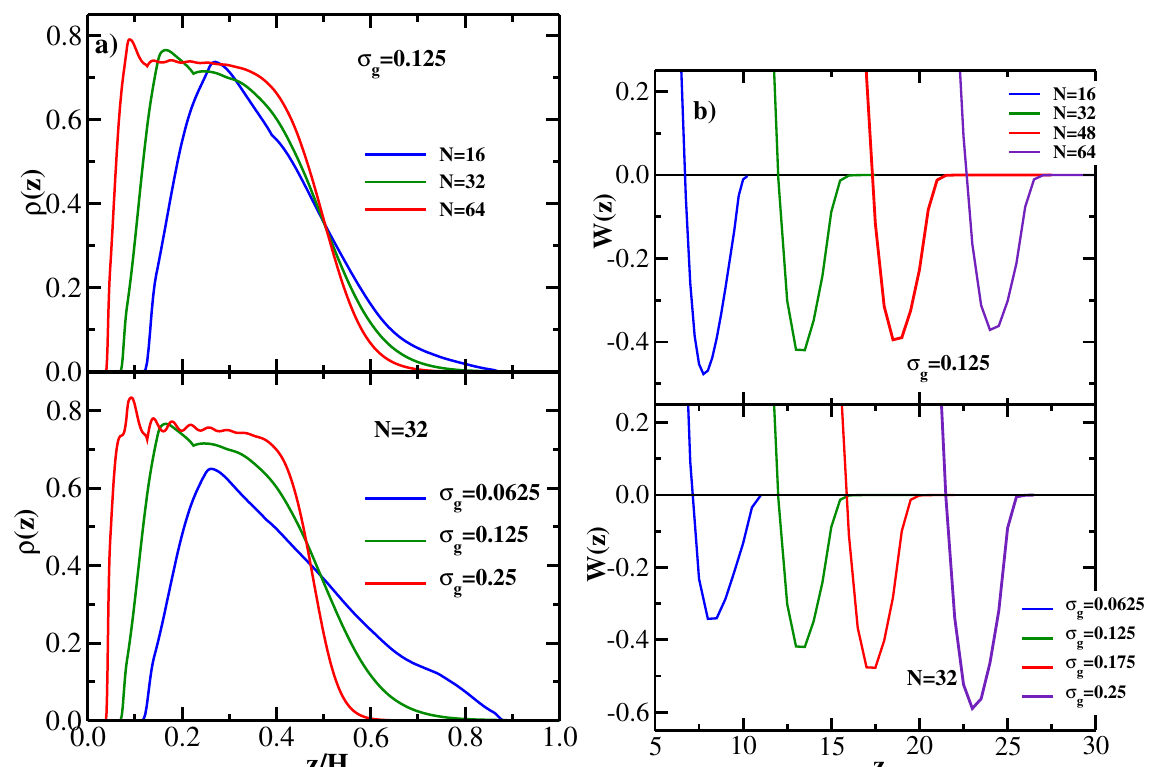
Figure 1. ( a ) Upper panel: DFT results for the equilibrium monomer density distributions for monodisperse flexible brushes at equilibrium separation H vs z / H ; grafting density is σ g = 0.125 and three values of the grafted chain length are considered: N = 16, 32, and 64. Only monomer density distributions of the chains grafted at the left wall are shown; the distributions of the chains grafted at the right wall are mirror-symmetric (around the mid-point of the gap between the walls) with respect to the left-wall grafted chains. Lower panel: DFT results for the equilibrium monomer density distributions for monodisperse flexible brushes at equilibrium separation H vs z / H ; grafted chain length is N = 32 and three values of grafting density are considered: σ g = 0.0625, σ g = 0.125, and σ g = 0.25. ( b ) Upper panel: PMF between two monodisperse flexible brushes as a function of wall-wall separation at the grafting density σ g = 0.125 for four values of the grafted chain length N , as indicated. Lower panel: PMF between two monodisperse flexible brushes as a function of wall-wall separation for the grafted chain length N = 32 for four values of the grafting density σ g , as